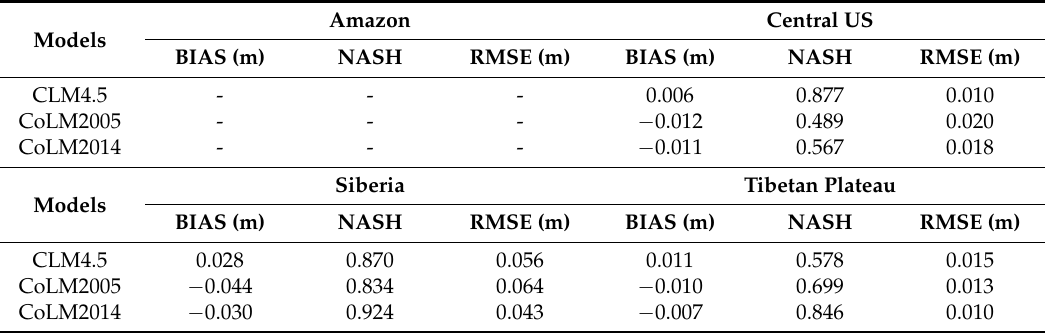
Table 3. Statistical summary of simulated snow depth annual